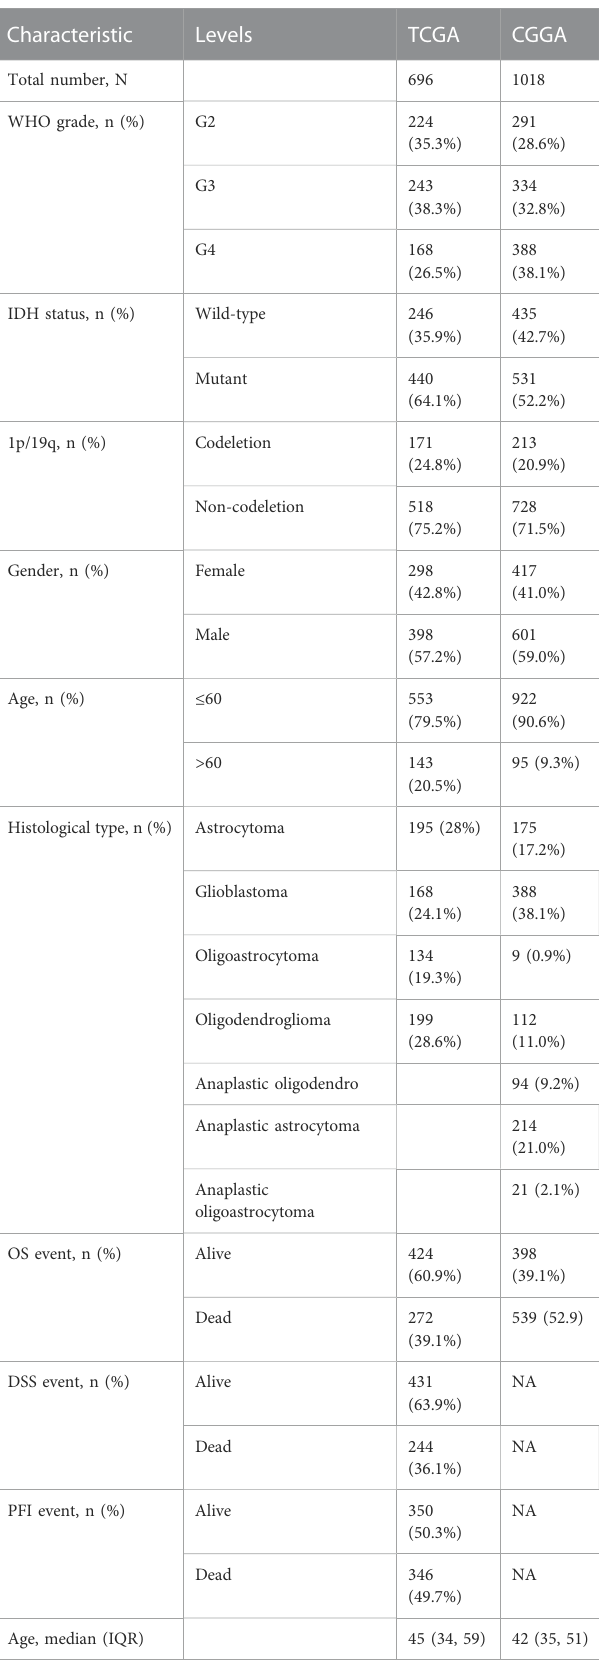
TABLE 1 The clinical characteristics of glioma